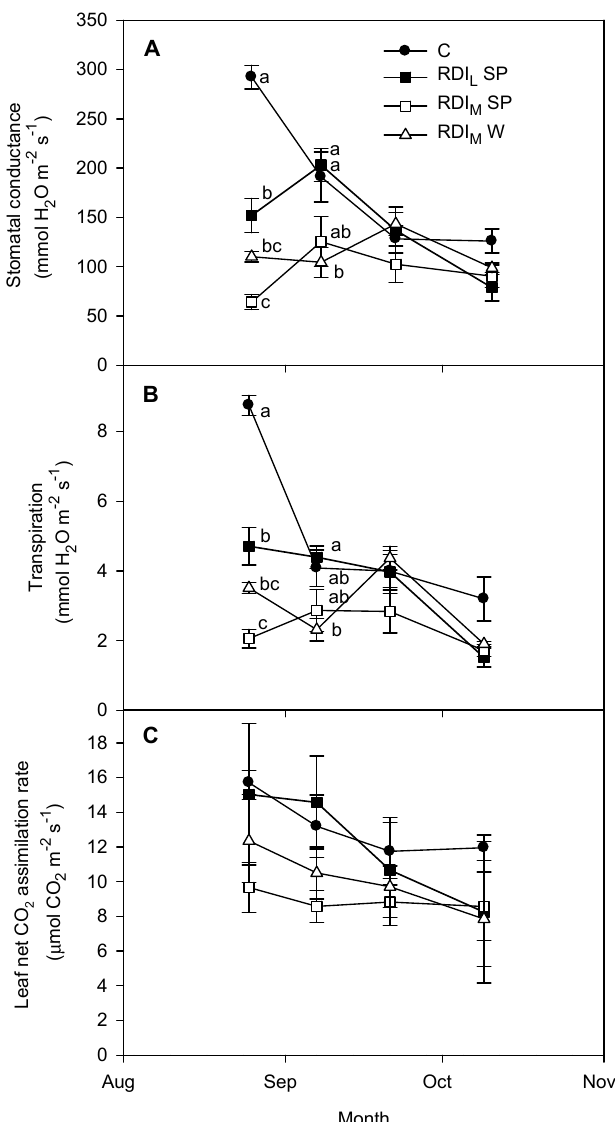
Figure 2. Seasonal variations in stomatal conductance ( A ), transpiration ( B ) and leaf net CO 2 assimilation rate ( C ) during the post-harvest period in 2015. Each value represents the mean of eight measurements and bars indicate the standard error of the mean. Different letters indicate significant differences ( P ≤ 0.05).